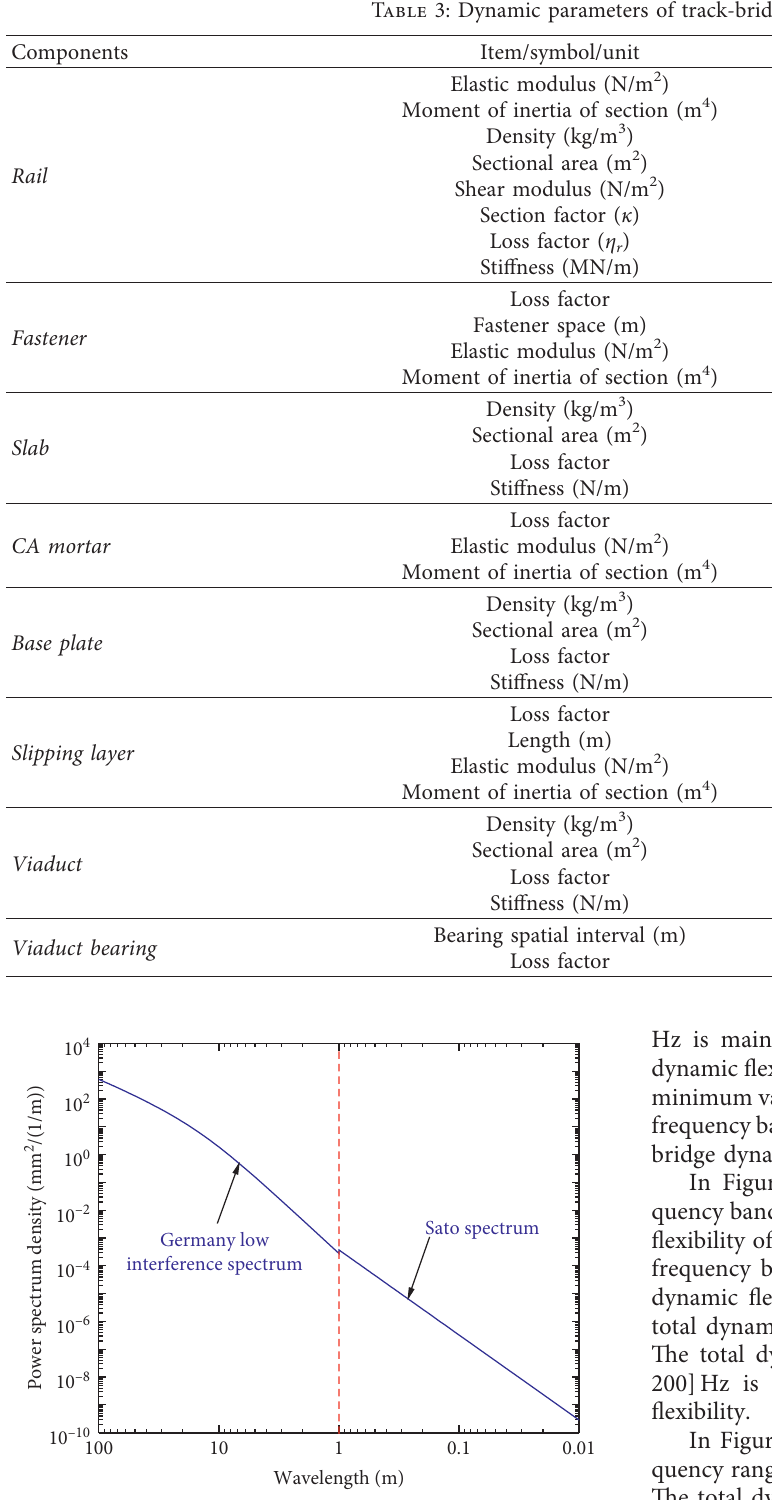
Figure 10: Irregularity